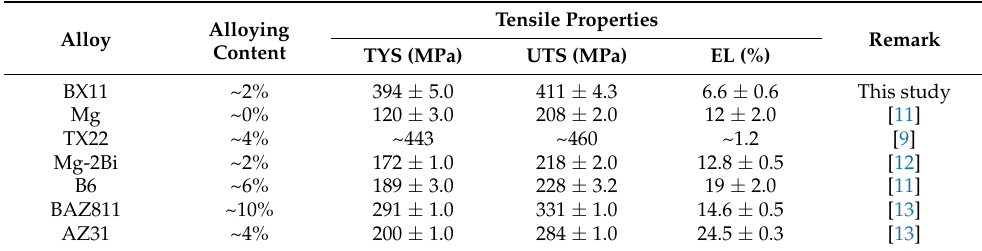
Table 1. Alloying content (wt.%) and mechanical properties of the BX11 alloy, compared with other typical magnesium alloys [9,11–13].